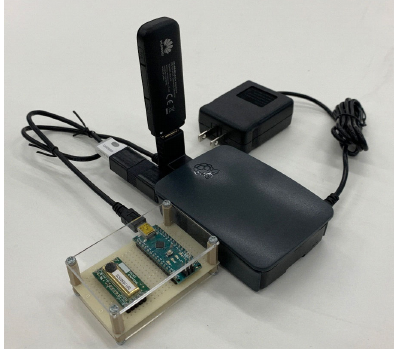
Figure 2. Sensor kit for measuring CO 2 concentration.